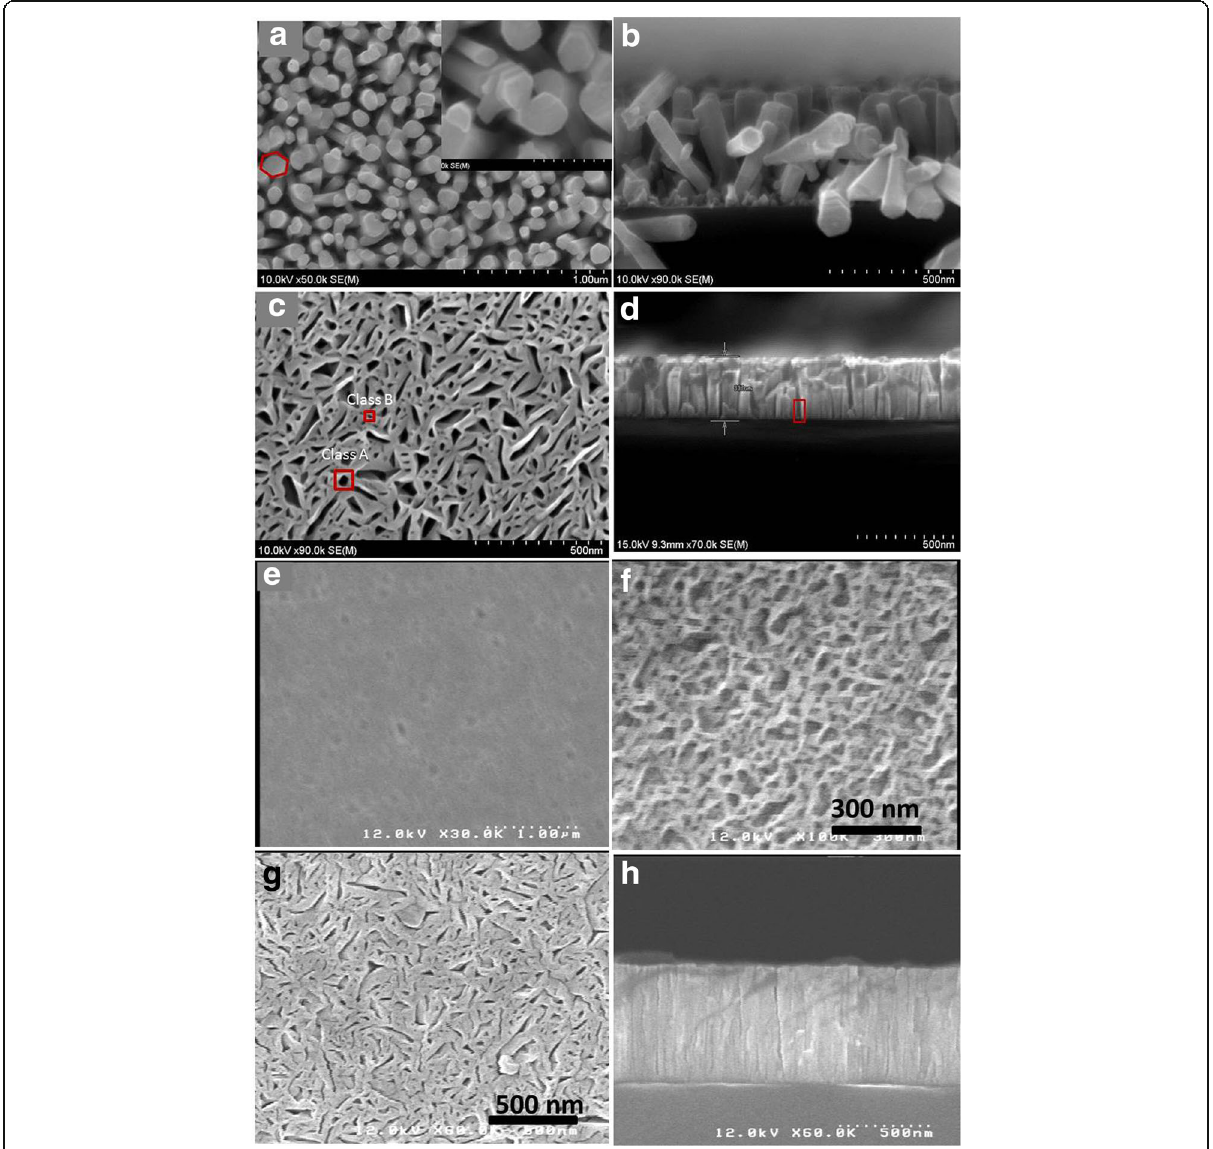
Fig. 1 FESEM images of samples grown at different conditions. a , b Corresponding to the GaN nanocolumns (sample S 1 ). c , d Corresponding to the GaN nanowall network (sample S 2 ), e Corresponding to the compact film (sample S 3 ), f Corresponding to the GaN nanowall network (sample S 4 ) at the beginning growth stage. g , h Corresponding to the GaN nanowall network grown at lower temperature 900 K (sample S 5 )